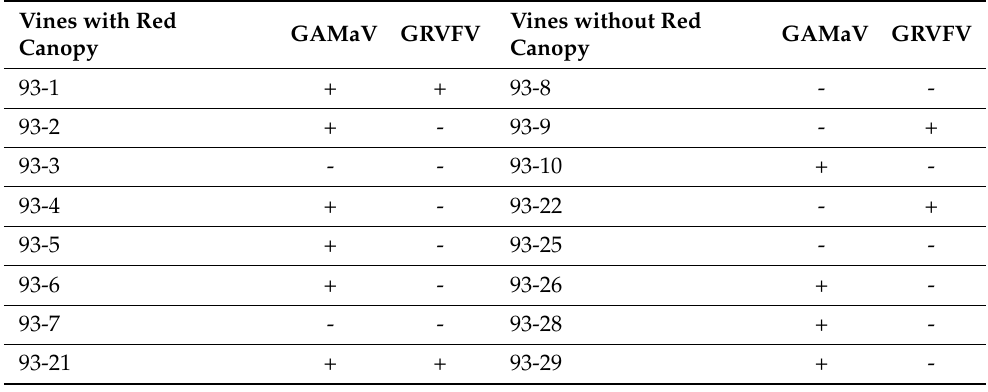
Table 6. RT-PCR detection of GRFVF and GAMaV from Syrah vines with and without Syrah decline